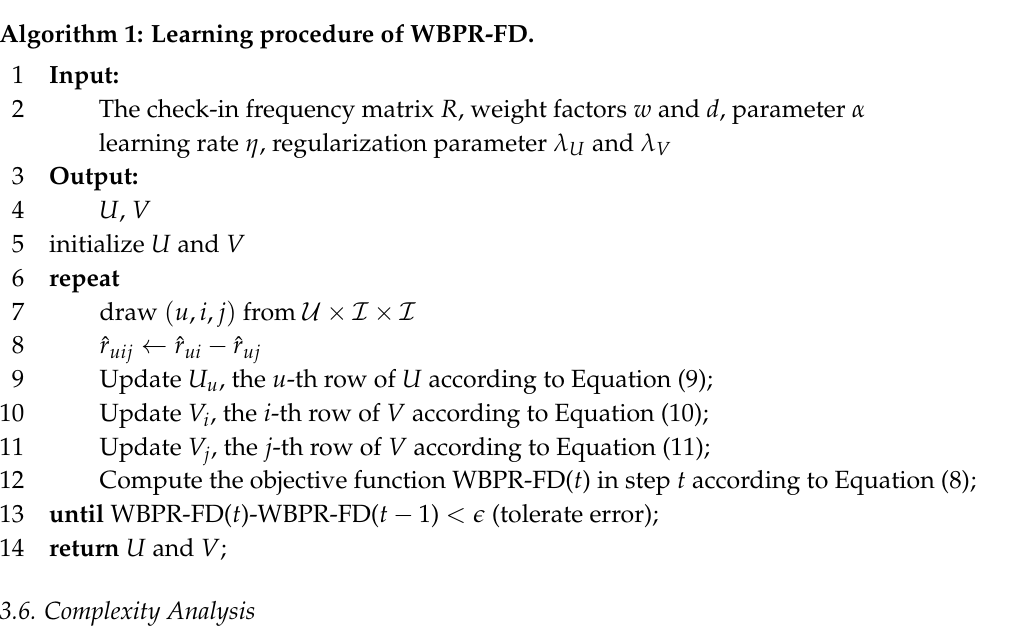
Algorithm 1: Learning procedure of